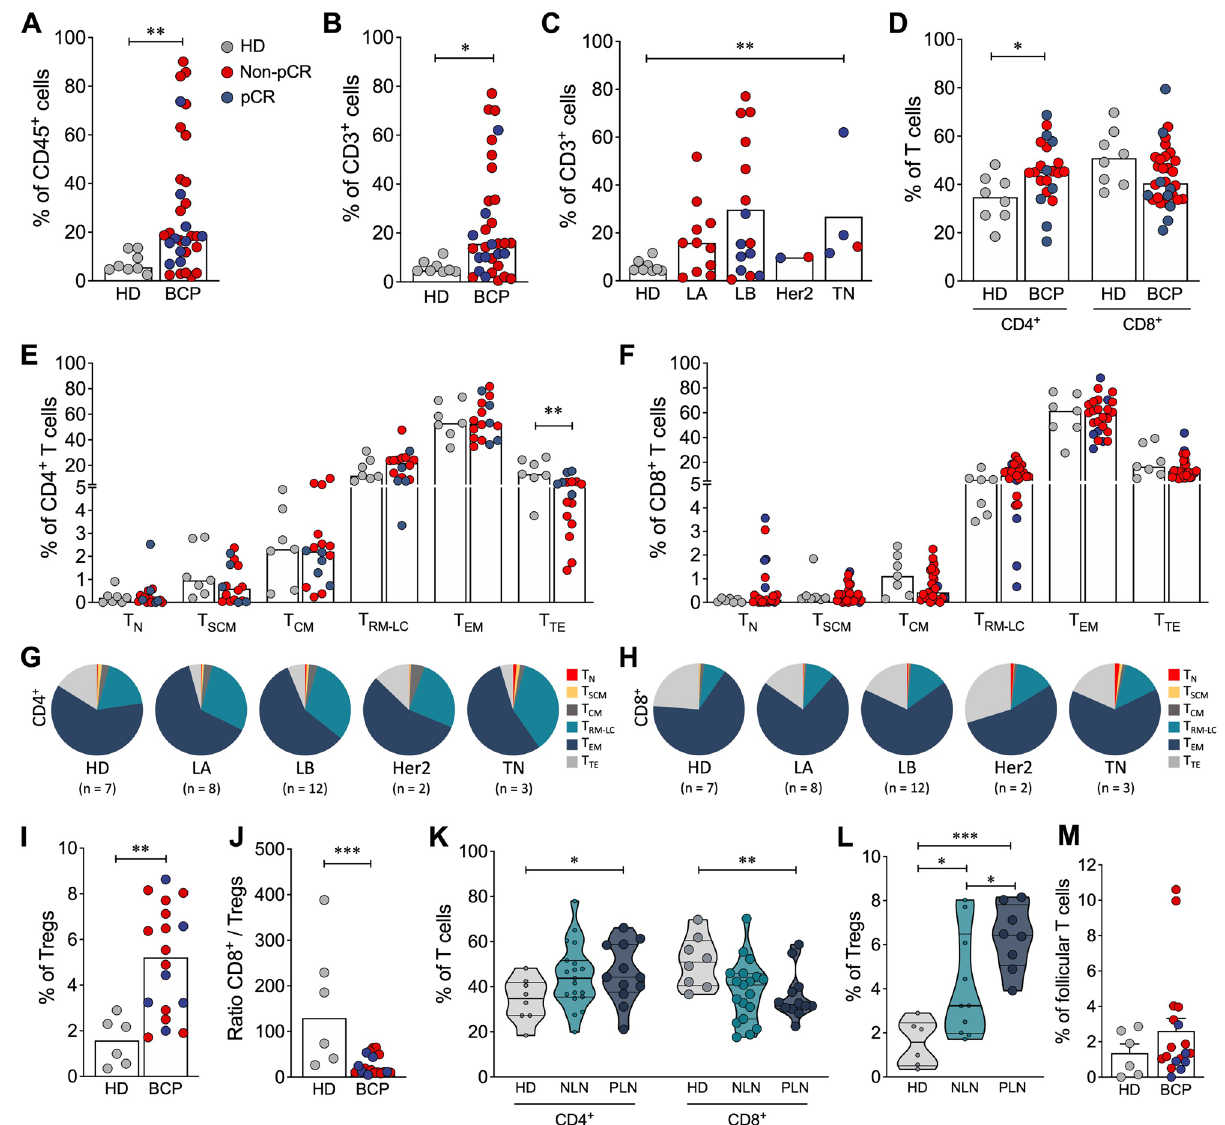
Figure 3. T cell composition in tumor and normal breast tissue. ( A ) Frequency of CD45 + cells from healthy donors (HD) and breast cancer patients (BCP). ( B ) Frequency of CD3 + cells from HD and BCP. ( C ) Frequency of CD3 + cells according to the molecular subtype of breast cancer: luminal A (LA), luminal B (LB), Her2 and triple negative (TN). ( D ) Percentage of CD4 + and CD8 + T cells. Distribution of memory subpopulations of CD4 + ( E ) and CD8 + T cells ( F ) evaluated using the CD45RA, CD62L, CCR7 and CD95 markers to define naïve (T N ), stem cell memory (T SCM ), central memory (T CM ), tissue-resident memory-like (T RM ), effector memory (T EM ) and terminally differentiated effector (T TE ) T cells. Pie charts of the distribution of CD4 + ( G ) and CD8 + T cell ( H ) memory subpopulations according to the molecular subtype of breast cancer. ( I ) Frequency of CD4 + CD25 + Foxp3 + regulatory T cells (Tregs). ( J ) Ratio of CD8 + /Treg cells. ( K ) Frequency of CD4 + and CD8 + T cells from HD and patients with positive lymph nodes (PLNs) or negative lymph nodes (NLNs). ( L ) Treg frequency according to the lymph node state. ( M ) Frequency of follicular T cells from healthy donors (HD) and breast cancer patients (BCP). Data are represented as the mean ± SEM in ( A, B, C, D, E, F, I, and J ). Data are represented as violin plots, and lines indicate quartiles in K and J. The p values were calculated using a Mann– Whitney test. * p < 0.05, ** p < 0.01, *** p <